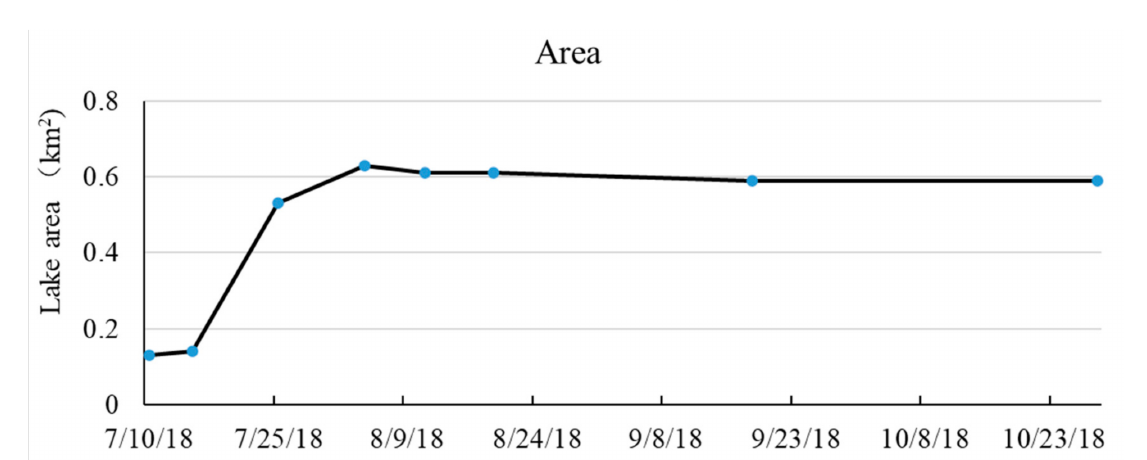
Figure 5. Variations in the area of Lake Badswat before and after the event.